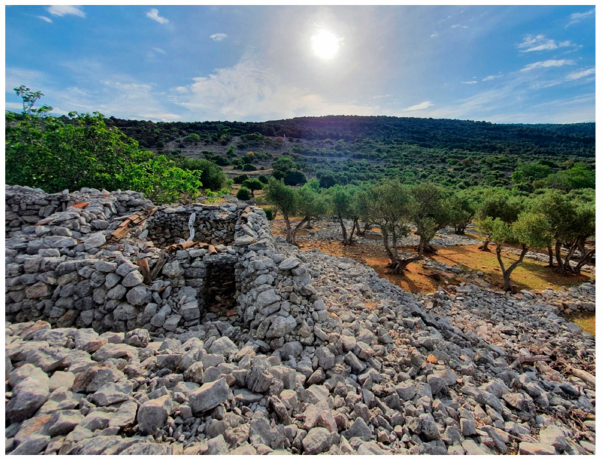
Figure 22. Dry stone wall shelters are for the most part rectangular and constructed on dry stone piles (Tanja Kremeni´c,